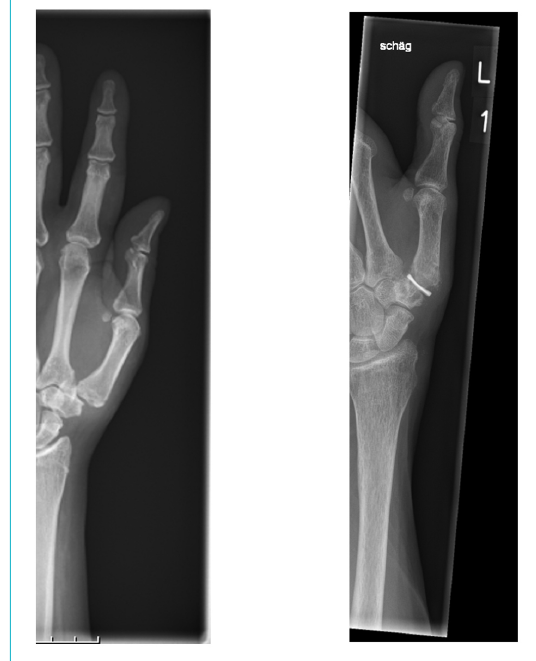
Figure 5: Implantation of a Pyrocardan ® spacer in the left thumb. Before (left) and after (right) implantation of Pyrocardan ® . After partial resection of the trapezial and first metacarpal bone, the spacer of pyrocarbon is interposed in the